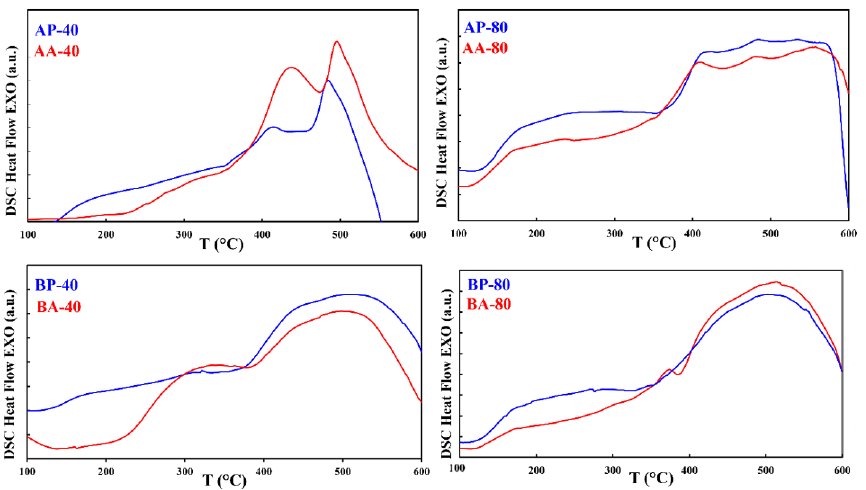
Figure 5. DSC curves collected in pairs for samples (AP-40 and AA-40), (AP-80 and AA-80), (BP-40 and BA-40), and (BP-80 and BA-80) to observe the behavior of powders and agglomerated particles after the same milling duration.